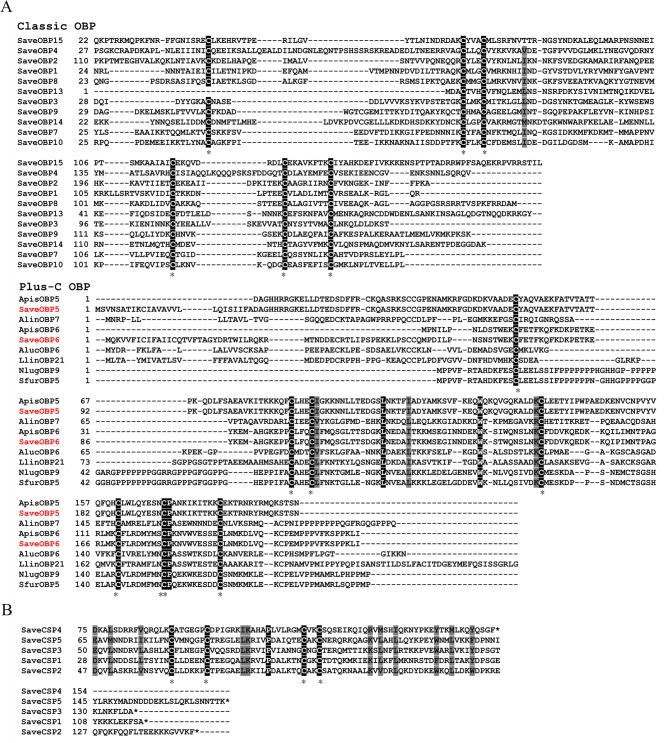
Alignment of amino acid sequences of the OBPs and CSPs in S. avenae.Sequences were aligned by Clustal Omega and edited using BoxShade. Black boxes show conserved cysteines. The conserved Cys residues are indicated. Shading represents sequence identity > 70%.